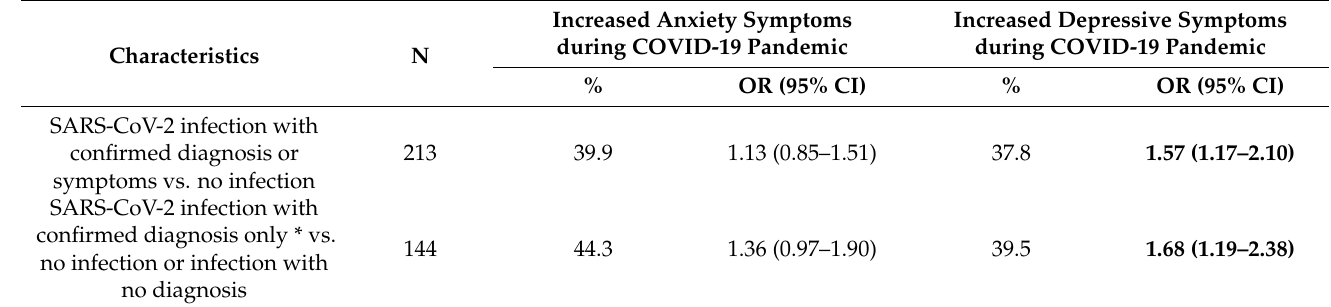
Table 3. Distribution of 4400 Italian subjects aged 65 years or above according to increased anxiety and depressive symptoms, by SARS-CoV-2 infection. Corresponding odds ratios ˆ (OR) and 95% confidence intervals (CI). Lombardy region, Italy,